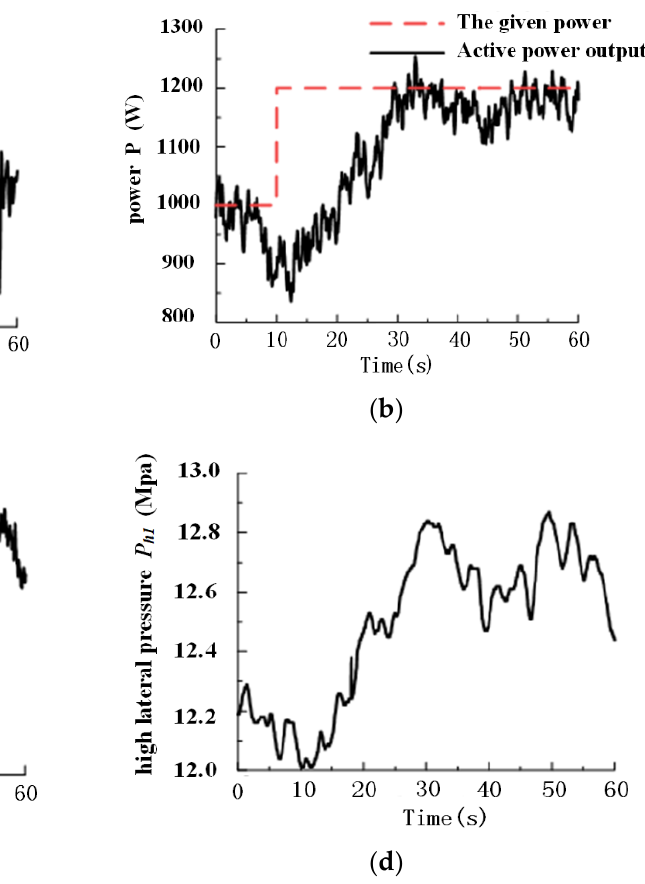
voltages. ( b ) Grid side frequency. ( c ) Three-phase currents. ( d ) Three-phase RMS voltages.